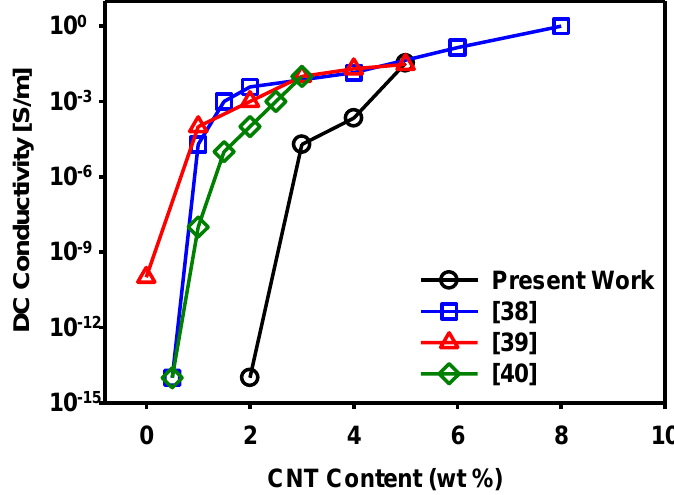
Figure 8. Variation of electrical conductivity with respect to the carbon nanotubes (CNT) content. The piezoresistivity was measured using resistance variation under loading. The MWCNT/TPU composites with a MWCNT concentration of 5 wt% were used. The resistance was measured under a tension up to a stretch of 1.4. Figure 9a shows the normalized resistance in terms of the stretch. The resistance increased at a faster rate in the longitudinal direction than in the transverse direction. The resistance data had the geometrical effect of deformation: the length between the electrodes increased in the longitudinal direction, whereas that in the transverse direction decreased during uniaxial tension. The normalized resistivities in the longitudinal and transverse directions agreed with each other, as shown in Figure 9b, implying that the isotropy of resistivity was preserved during deformation.